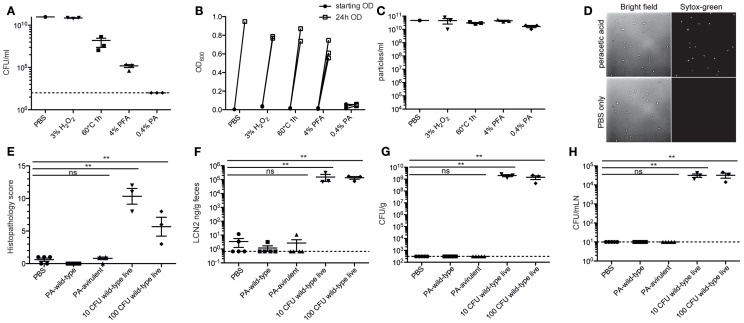
Peracetic acid highly efficiently kills bacteria, with minimal lysis. (A–D) Avirulent S. Typhimurium was cultured overnight to stationary phase, concentrated, and inactivated by incubating in 3% H2O2 for 1 h, heating to 60°C for 1 h, incubating in 4% PFA/PBS for 1 h, or incubating in 0.4% peracetic acid for 1 h. All aliquots were subsequently washed three times to remove fixatives/oxidizing agents before resuspending for CFU analysis by plating (A) and total sterility by enrichment culture (B). Lysis was determined by counting bacterial particles by flow cytometry (C). To examine morphology, the bacteria were diluted in PBS containing 0.5 μM Sytox-green and were imaged by bright-field and fluorescence microscopy at 100× magnification (D). One representative experiment of two. (E–H) C57BL/6 LCM mice received 1.0 g/kg streptomycin p.o. 24 h before oral gavage of 5 × 1010 particles of peracetic acid-inactivated wild-type S. Typhimurium SB300 (PA-wild-type), 5 × 1010 particles of peracetic acid-inactivated avirulent S. Typhimurium M2702 (PA-avirulent), or 10 CFU or 100 CFU of wild-type live S. Typhimurium SB300. After 72 h, all animals were analyzed. (E,F) Intestinal pathology as determined by histopathology or fecal Lipocalin 2 (LCN2). Kruskal–Wallis test, P = 0.0023 (G,H). Cecal content (Kruskal–Wallis test, P = 0.0007) and mesenteric lymph node CFU (Kruskal–Wallis test, P = 0.0007). **Dunn’s post-test, P < 0.01. One experiment with three to five mice per group.